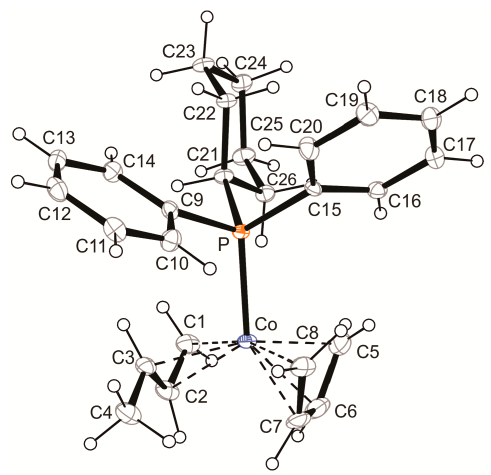
Figure 1. Molecular structure of ( η 3 ‐ C 4 H 7 )( η 4 ‐ C 4 H 6 )Co(PCyPh 2 ) ( 1 ) with thermal ellipsoids drawn at 30% probability level.